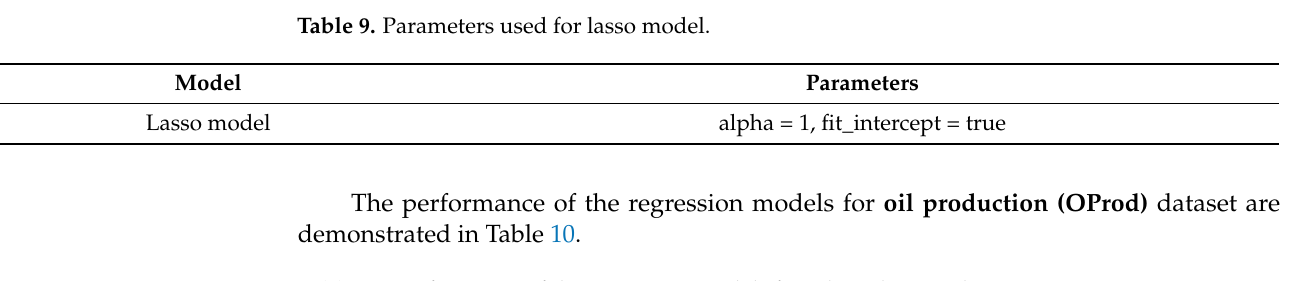
Table 10. Performance of the regression models for oil production